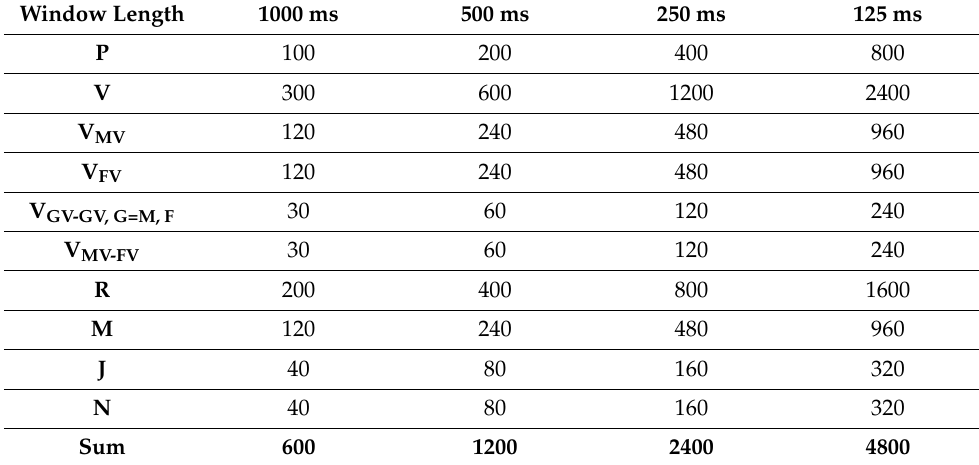
Table 1. Population of annotated audio